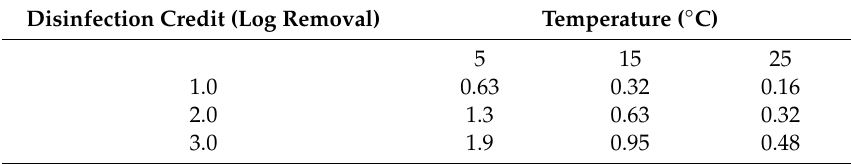
Table 5. Disinfection credits and CT values in mg-min / L for inactivation of Giardia cysts by ozone, as noted by the United States Environmental Protection Agency (USEPA), 1991. [178].